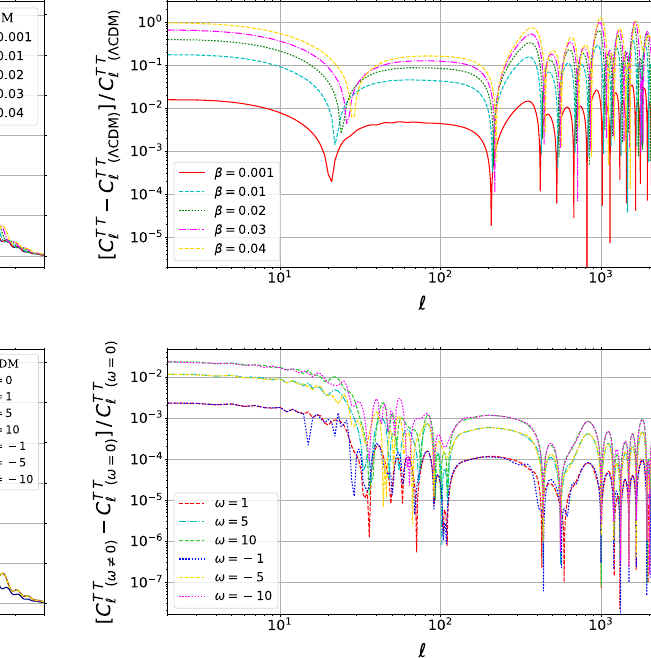
CMB power spectra diagrams for different values of ω , considering β = 0 . 04, compared to (cid:3) CDM model (left) and their relative ratio with respect to the case ω = 0 (right)